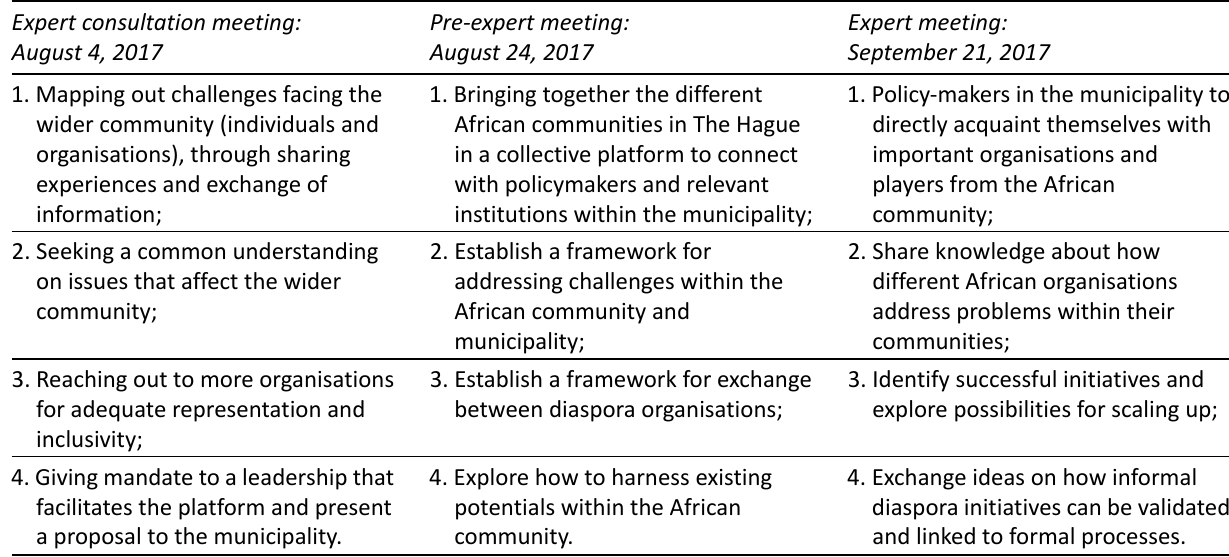
Table 2. Objectives of consultative meetings. Source: Focus Group Discussions, August 4 and 24, and September 21,